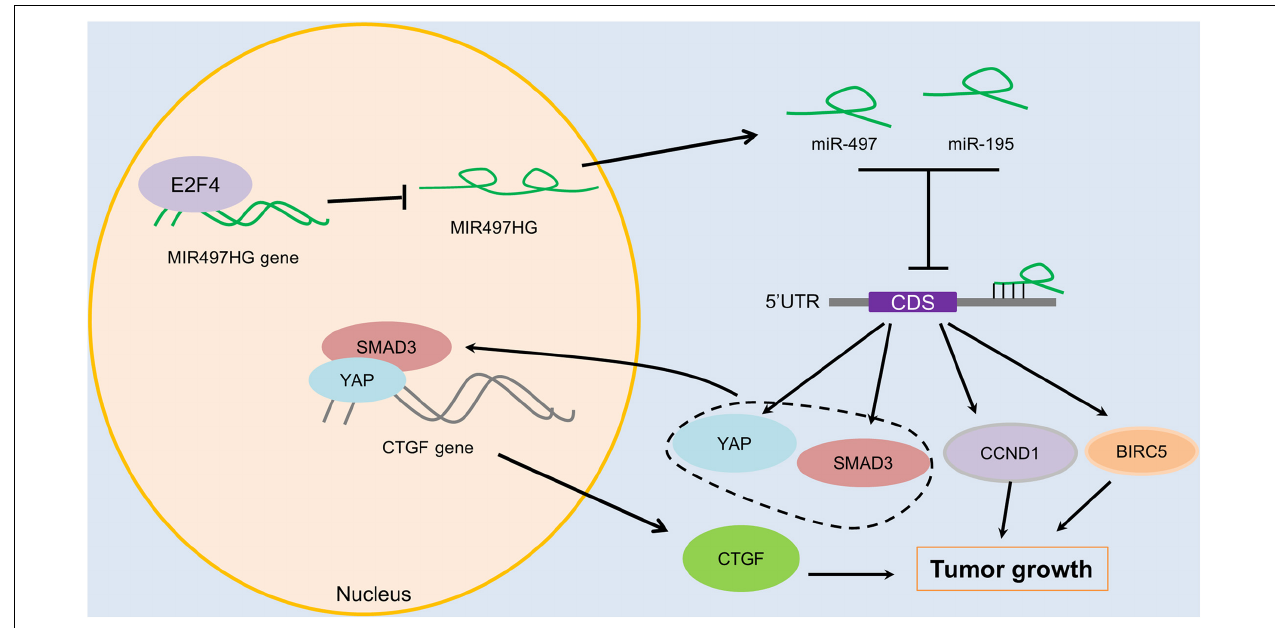
FIGURE 7 | The schematic diagram of mechanism of lncRNA MIR497HG in BCa. E2F4 bound to the promoter of MIR497HG to act as inhibitory transcription factors to suppress the expression of MIR497HG. miR-497 and miR-195 were derived from MIR497HG, and they suppressed the crosstalk of Yap and SMAD3, which were key components in Hippo/Yap and TGF- β /Smad signaling. Then, the downstream of Yap/SMAD3 complex, oncogenic CTGF, was restrained to curb cell progression of BCa.